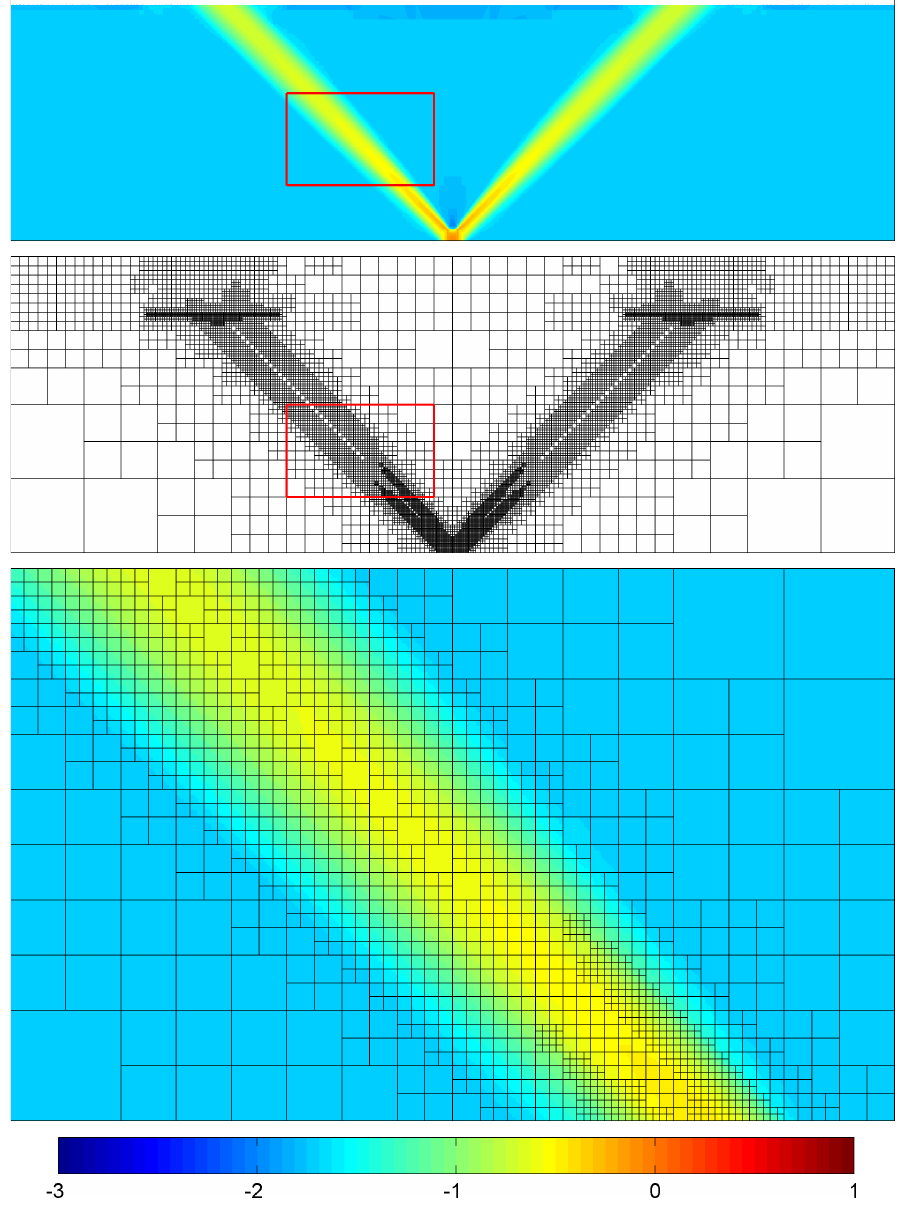
Figure 19. Extension model with φ = 0 ◦ after 0.07% strain; top : log ( ˙ ε II ) plot; middle : numerical grid; bottom : zoom as marked by red